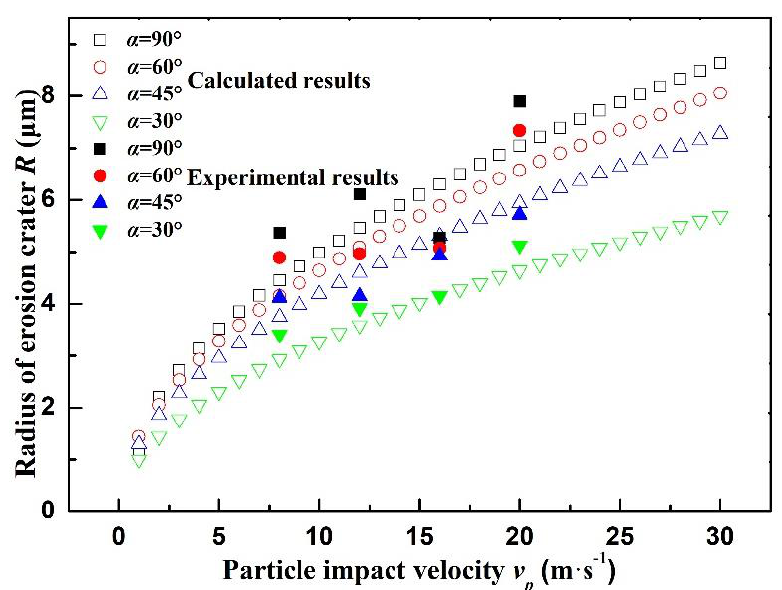
Figure 10. Comparison between calculated values and experimental values of crater radius.